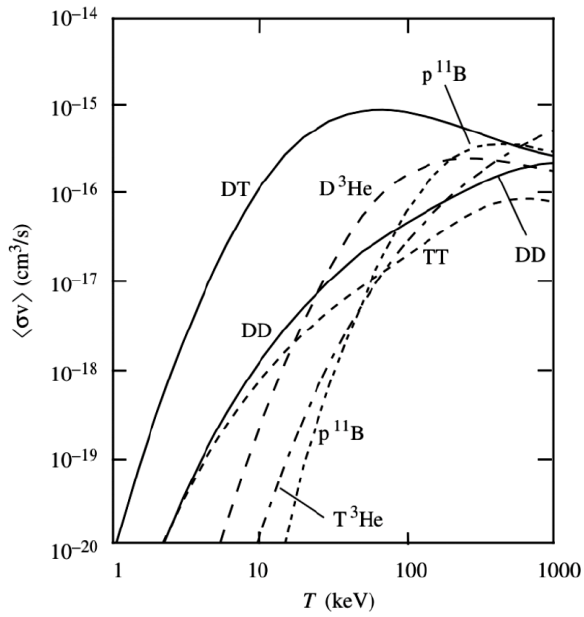
Figure 1. Reactivity averaged over a Maxwell–Boltzmann distribution as a function of plasma temperature, from [2].